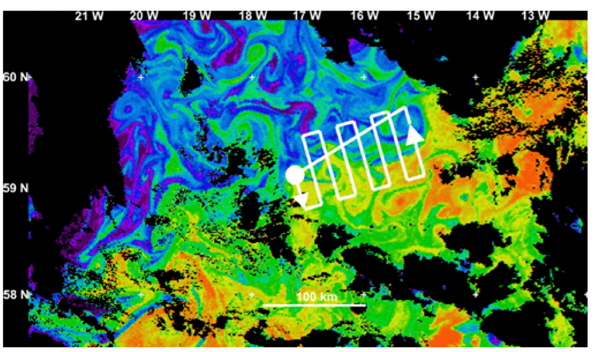
Fig. 1. This example shows chlorophyll concentration in a snapshot image of 11 June 2009 south of Iceland. Here the chlorophyll acts as a tracer of physical structures, mesoscale eddies and “hammerhead” structures, showing stirring of the ocean on scales of 1–50Km. The UAV survey (taking nine hours) would result in less smearing (be more synoptic) than a ship survey that would take more than thirty hours. Image produced by the NERC Earth Observation Data Ac- quisition and Analysis Service,